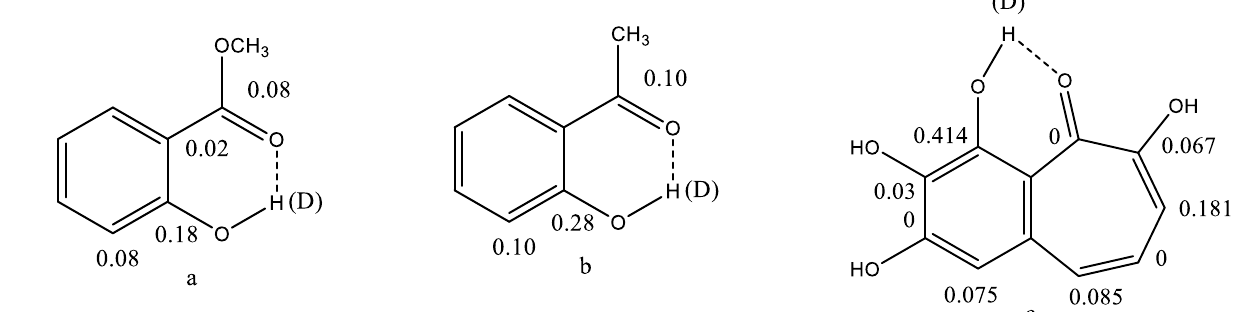
Figure 2. Deuterium isotope effects on 13 C chemical shifts in ppm. Methyl salicylate ( a ) and o -hydroxyacetophenone ( b ). Taken from Ref. [14]. Purpurogallin ( c ). Only isotope effects due to the included deuterium are shown for clarity. In ( c ), the other OH groups are, of course, also deuterated. From Ref. [14].